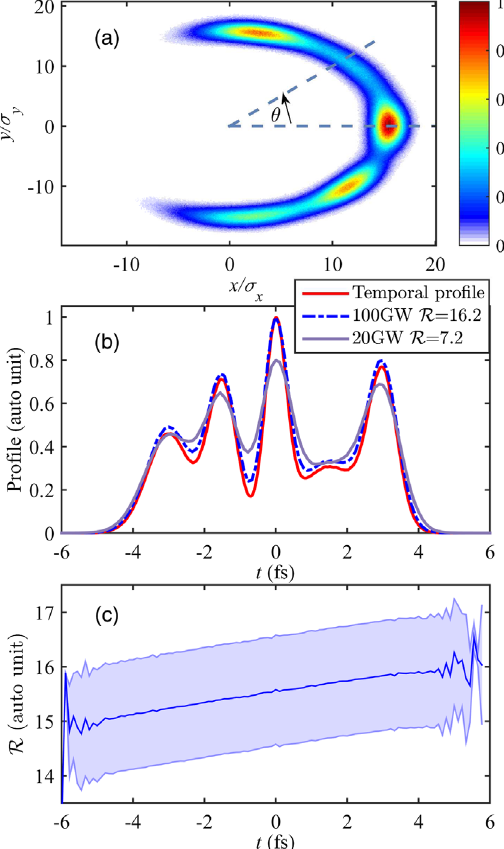
FIG. 3. Circular deflector results: (a) ring pattern at the final screen when the laser power is 100 GW; (b) actual and reconstructed beam current profiles with laser power 100 GW and 20 GW; (c) the average ring radius along the beam time coordinate with laser power 100 GW. The shadow is the rms width of the radius.